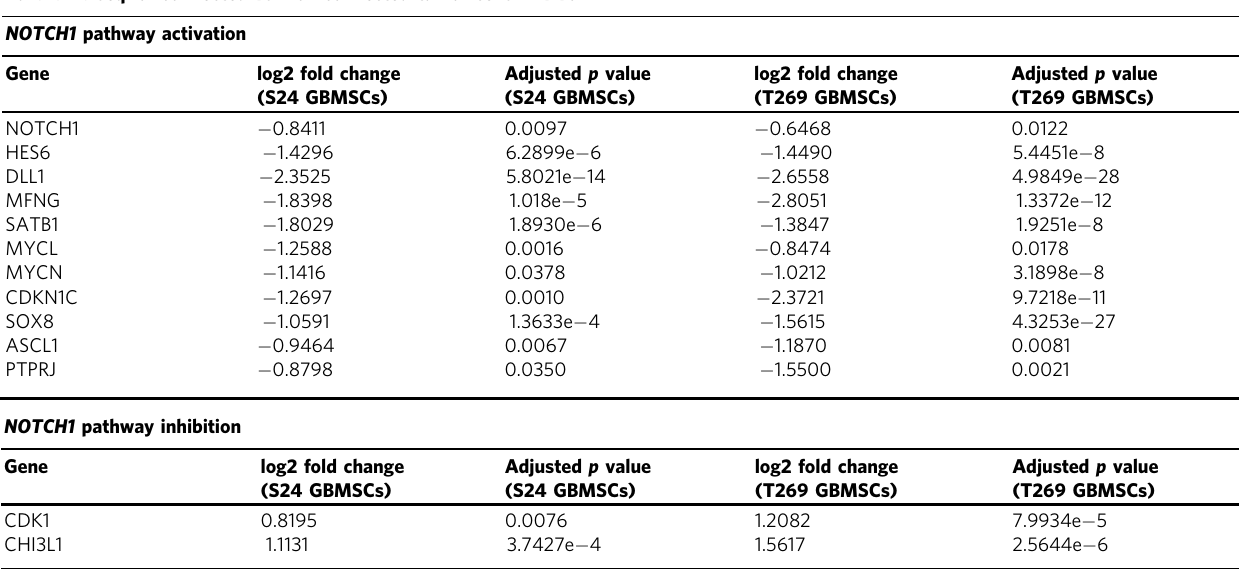
Table 1 Interconnected tumor cells exhibit NOTCH1 pathway